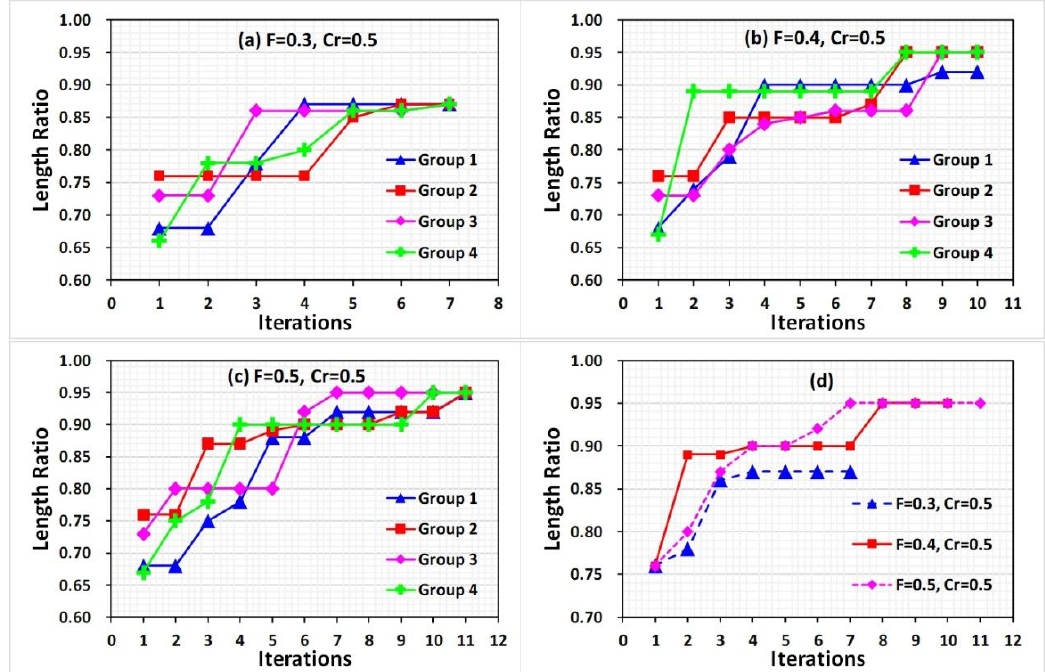
Figure 4. Differential evolution based on the length ratio in feedback control for pushing CNT operation with ( a ) F = 0.3, ( b ) F = 0.4, and ( c ) F = 0.5. The peak length ratio value in each step iteration of every set is listed in ( d ). In each iteration, four groups of combinations were studied.